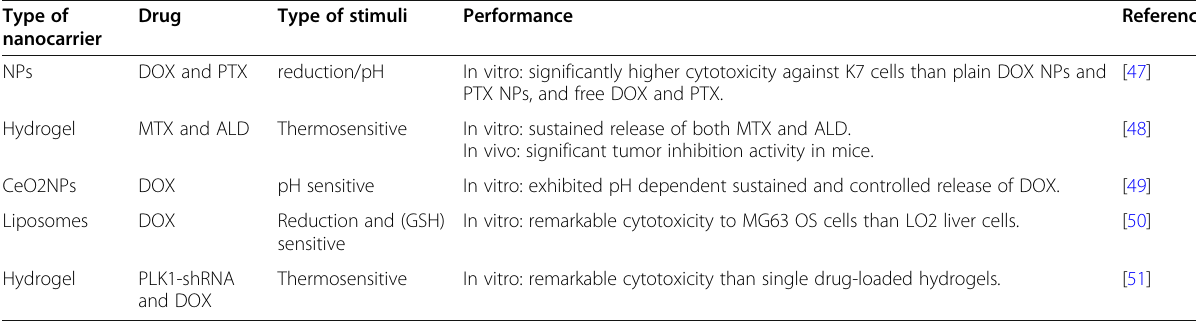
Table 2 The reported stimuli-responsive nanocarriers for the treatment of OS Type of